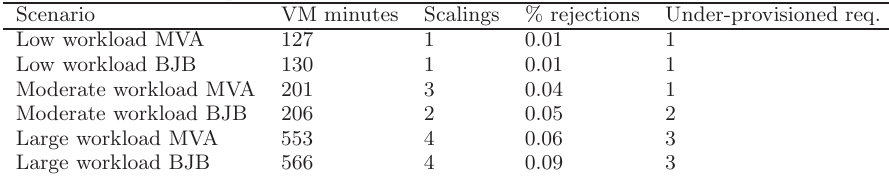
Table 4: Cost and performance results obtained with the scientific benchmark Scenario